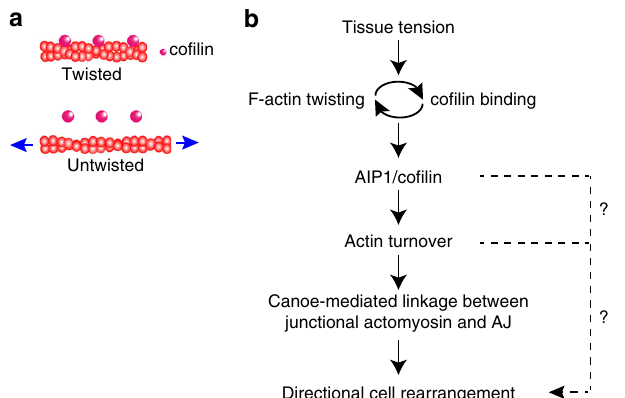
Fig. 10 Summary and working hypothesis. a Schematic showing tension on actin fi laments and their twisting, which have been reported by previous studies using in vitro reconstituted actin fi laments 15, 17 – 19 . Actin fi laments (red) alter their helical pitch in response to applied forces (blue arrows). co fi lin (magenta) preferentially binds to twisted, mechanically relaxed actin fi laments. b Summary of the working hypothesis. See the main text for details. Upper and bottom dashed arrows indicate an unidenti fi ed pathway regulating directional cell rearrangement downstream to AIP1/co fi lin or actin turnover, which may potentially function via E-cad transport